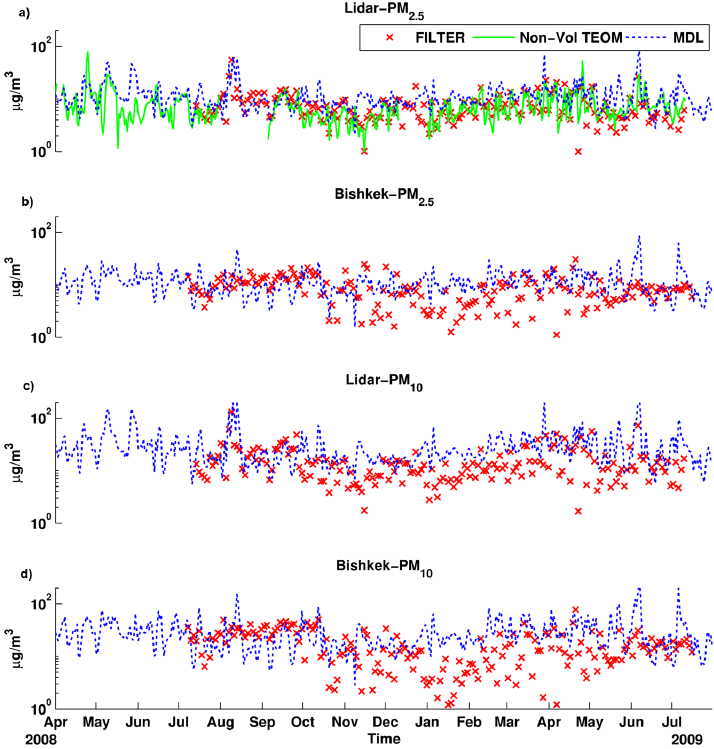
Figure 9. Comparison of simulated PM mass with filter-based observations at Central Asian sites. (a) PM 2 . 5 (LST) along with TEOM non-volatile measurements, (b) PM 2 . 5 (Bishkek), (c) PM 10 (LST), and (d) PM 10 (Bishkek) in (µgm − 3 ) . “Lidar” denotes the LST